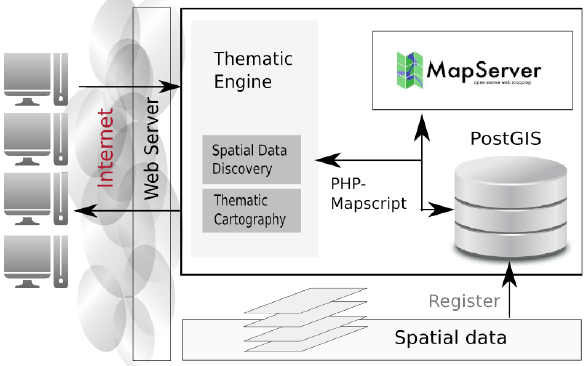
Figure 4. System architecture of Thematic Mapping Service